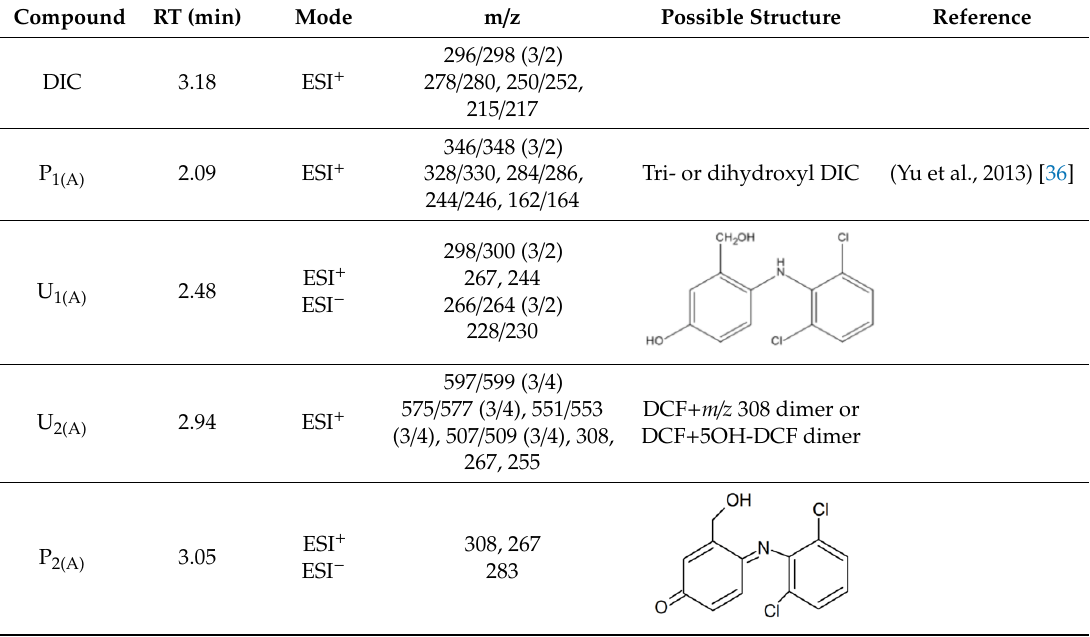
Table 1. MS (mass spectroscopy) data of products in the absence of CTAB.